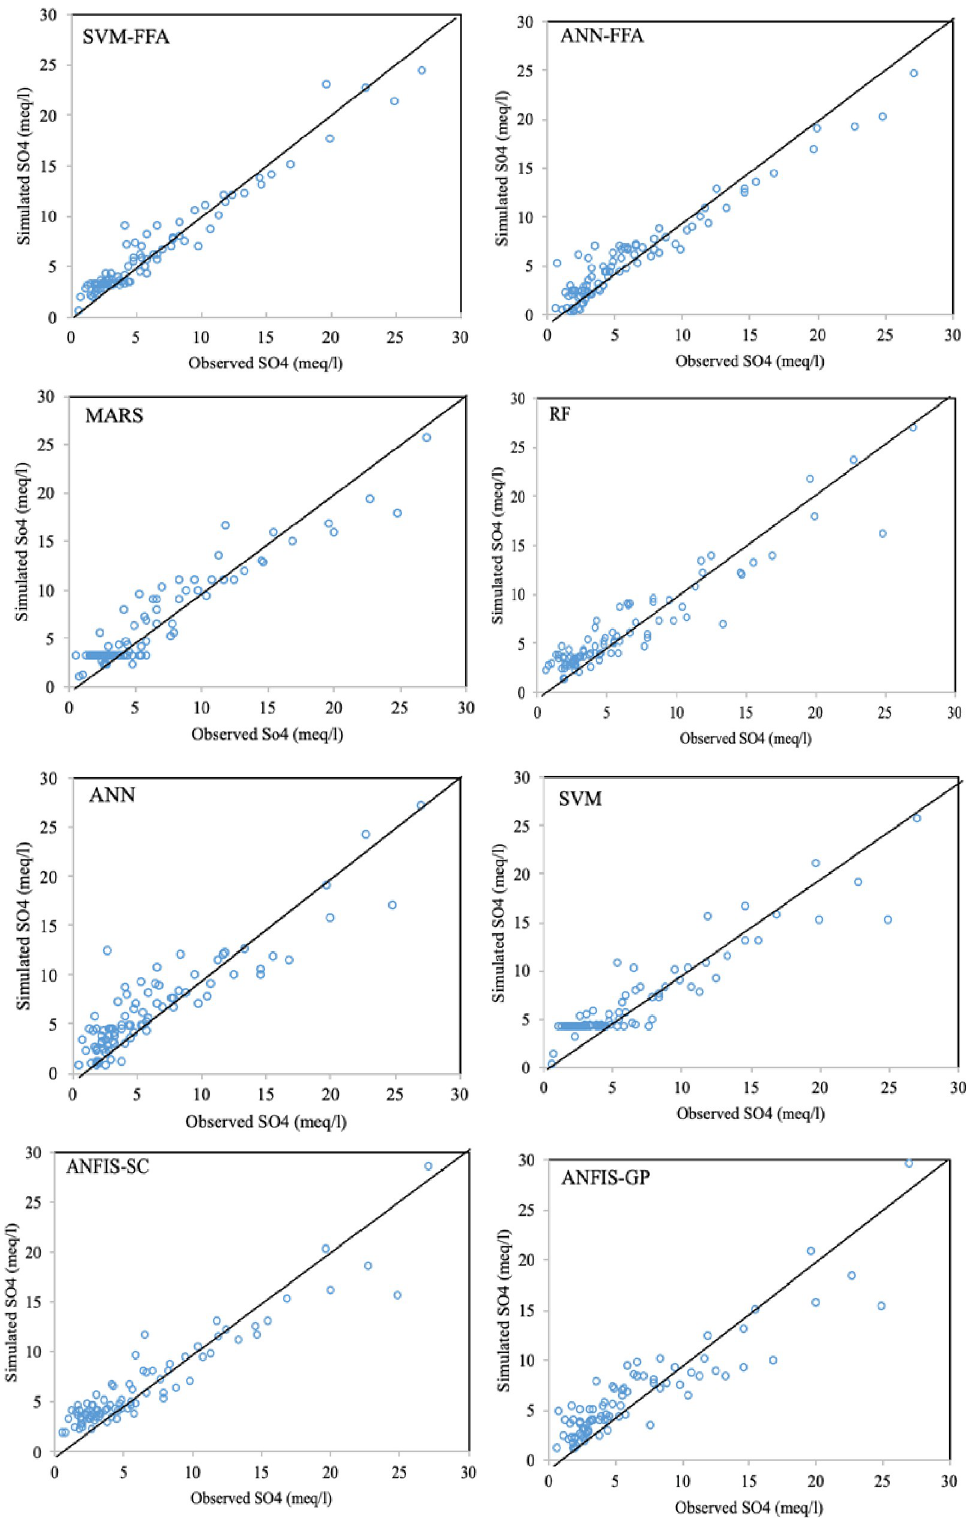
Fig 9. The scatterplots of the predicted SO 4 using the applied AI models.